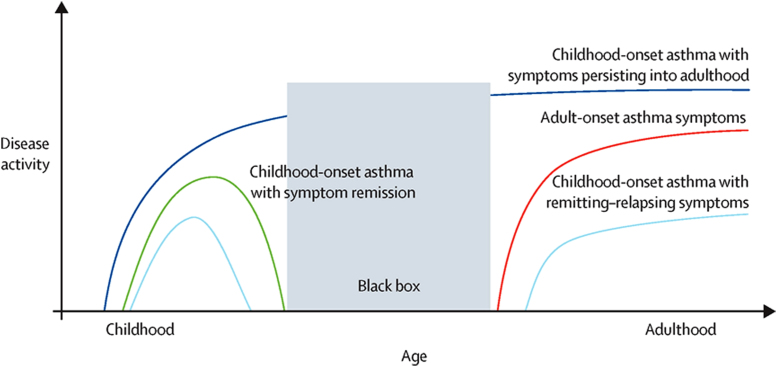
Prognosis of childhood asthma. Some infant asthma grow up to persistent asthma by age raised. The other infant asthma grow up to asthma symptoms free by age raised. Prognosis (predictive) factors play an important roles weather asthma symptoms are persistent or free.